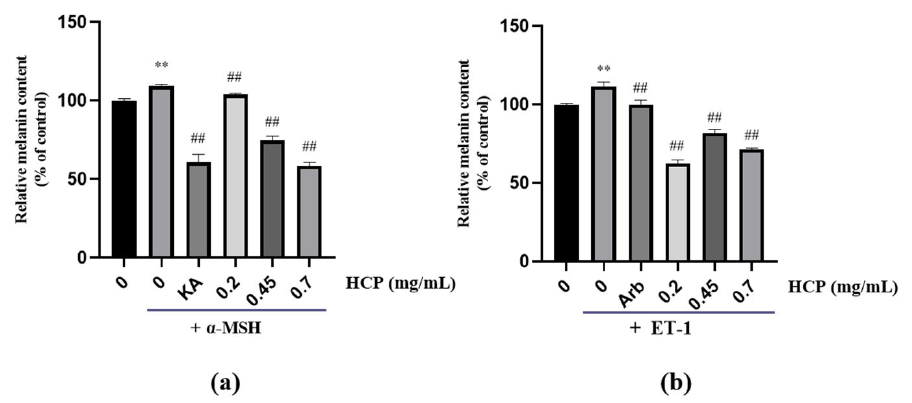
Figure 3. ( a ) HCP inhibits α -MSH-induced melanogenesis in MNT-1 melanoma cells. Kojic acid (KA, 0.2 mg/mL) was used as a positive control. ( b ) HCP inhibits ET-1-induced melanogenesis in MNT-1 melanoma cells. α -arbutin (Arb, 0.2 mg/mL) was used as a positive control. All data are expressed as